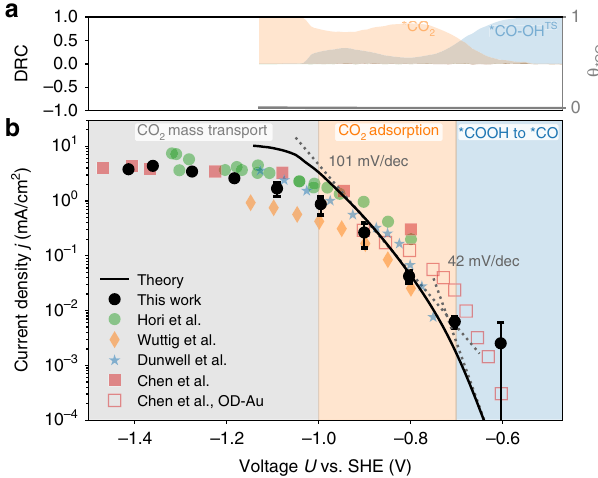
Fig. 5 Multiscale CO 2 reduction simulation results compared with experiment. a Simulated degree of rate control (DRC), where a positive (negative) value indicates that the considered reaction intermediate needs to be stabilized (destabilized) in order to enhance the rate, and boundary values of 1 and − 1 represent full rate control by the intermediate. *CO – OH refers to the *COOH to *CO transition state. The *CO coverage is shown as a gray line (plotted with respect to the right axis). b CO polarization curve, where the solid line shows the multiscale simulation result compared with experimental results from this work (0.1 M KHCO 3 , pH = 6.8, black fi lled circles) and previous studies using 0.5 M KHCO 3 (pH = 7.2) of Dunwell et al. 6 , Wuttig et al. 3 , Hori et al. 36 , and Chen et al 37 . ( fi lled colored symbols). Data have been generally obtained using polycrystalline Gold electrodes, despite the additionally shown data from ref. 37 on oxygen- derived nanoporous Gold electrodes (normalized using a roughness factor of 72). Tafel slopes from our model are indicated with the dotted